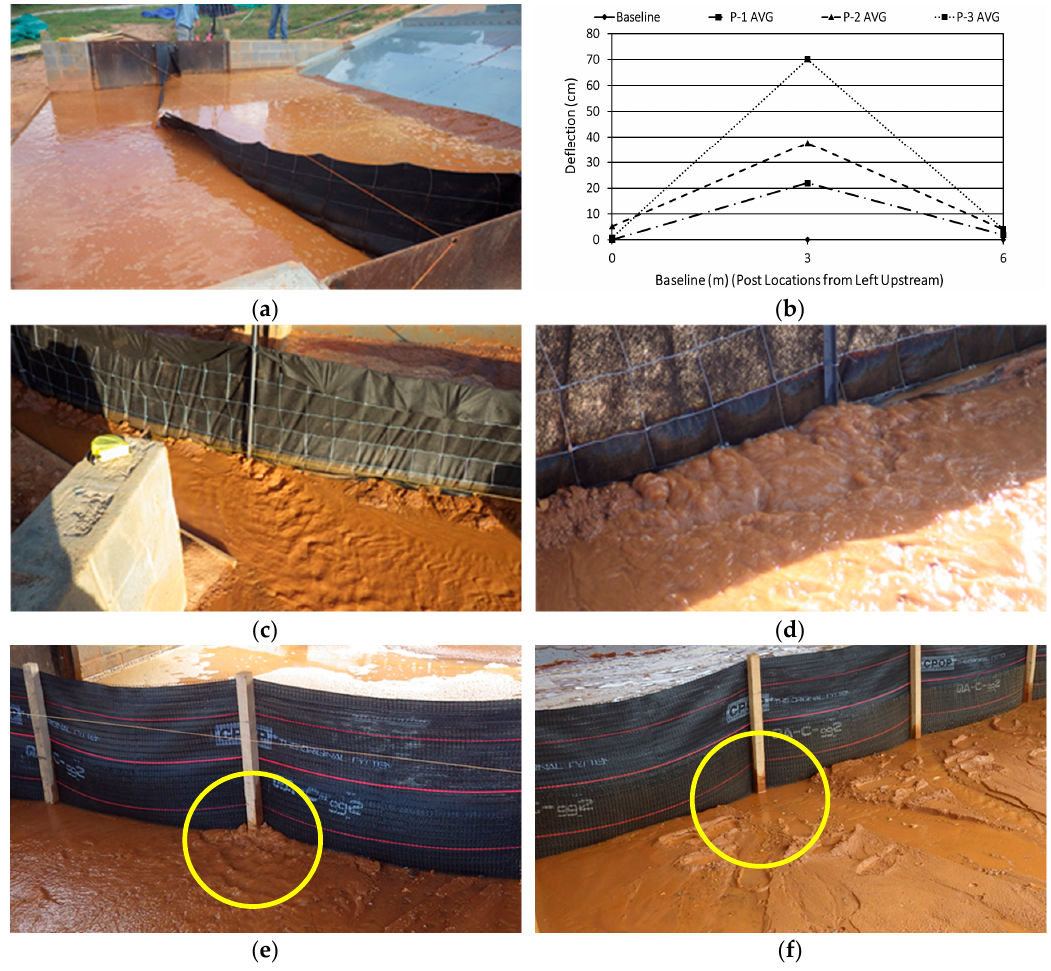
Figure 3. Silt fence installation failure modes, ( a ) ALDOT Trenched Silt Fence during test P-3, ( b ) ALDOT Trenched Silt Fence t-post deflection during testing, ( c ) Undercutting ALDOT Sliced Silt Fence , I-1, ( d ) Undercutting ALDOT Sliced Silt Fence , I-2, ( e ) AL-SWCC Trenched Silt Fence , Post #5, I-2, Test